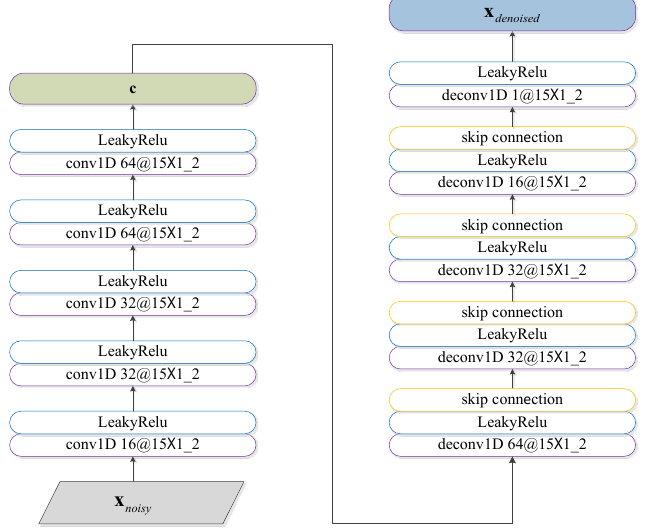
Figure 3. Detailed structure of the generator.